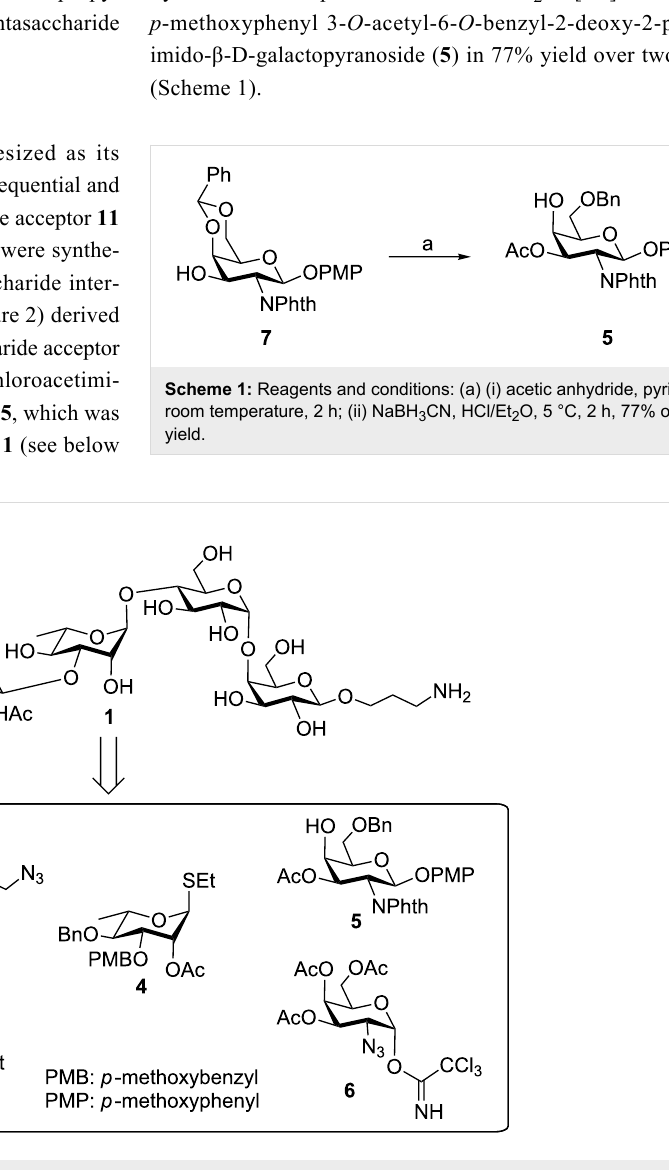
Figure 2: Structure of the synthesized pentasaccharide ( 1 ) and its precursor